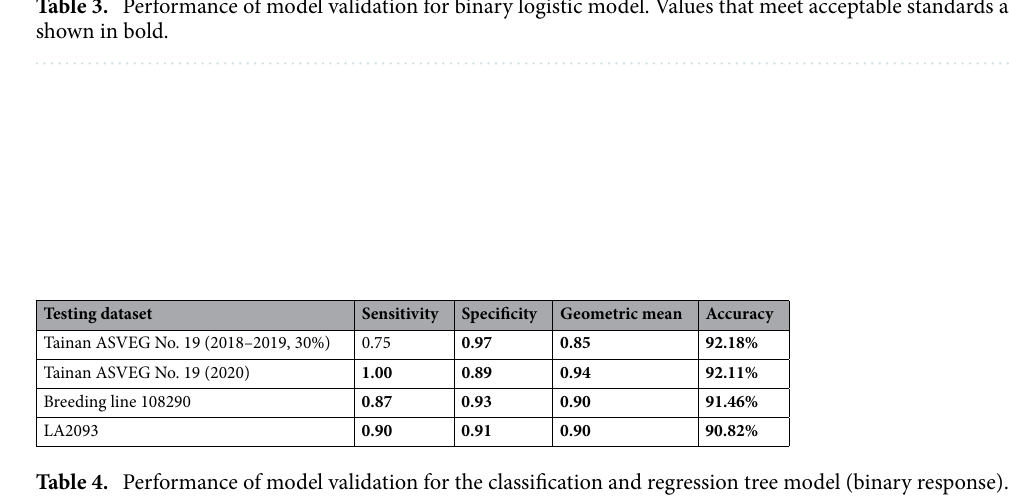
Table 4. Performance of model validation for the classification and regression tree model (binary response). Values that meet acceptable standards are shown in